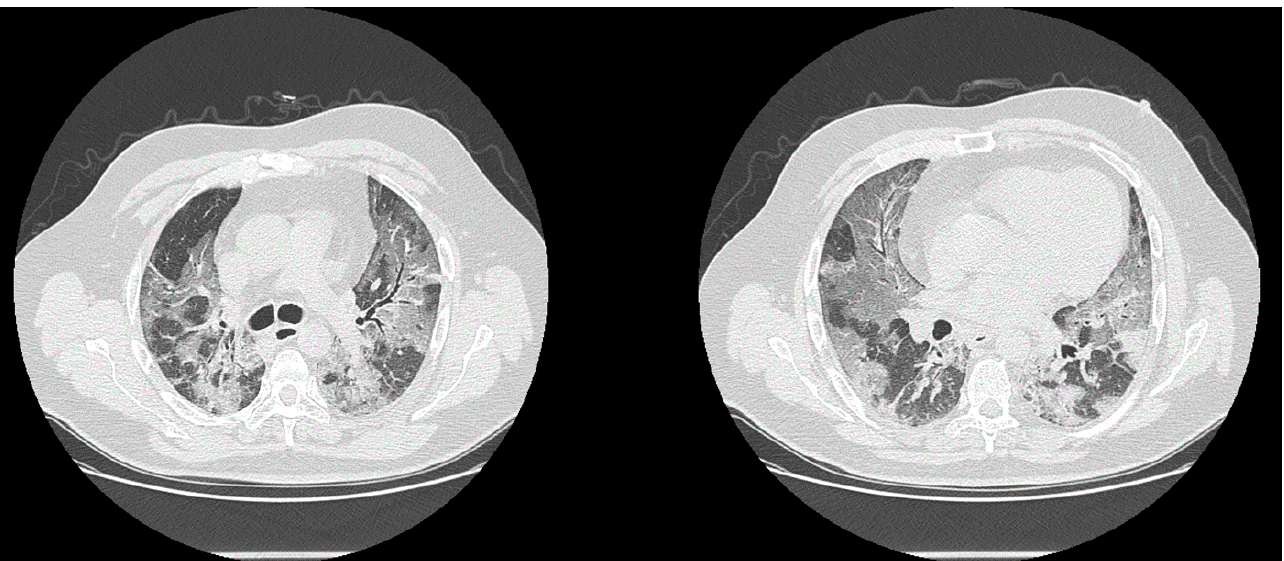
Figure 5. The CT images show a typical aspect of bilateral extended crazy paving characterized by GGO with septal thick- ening, patchy distribution, and aerial bronchogram.